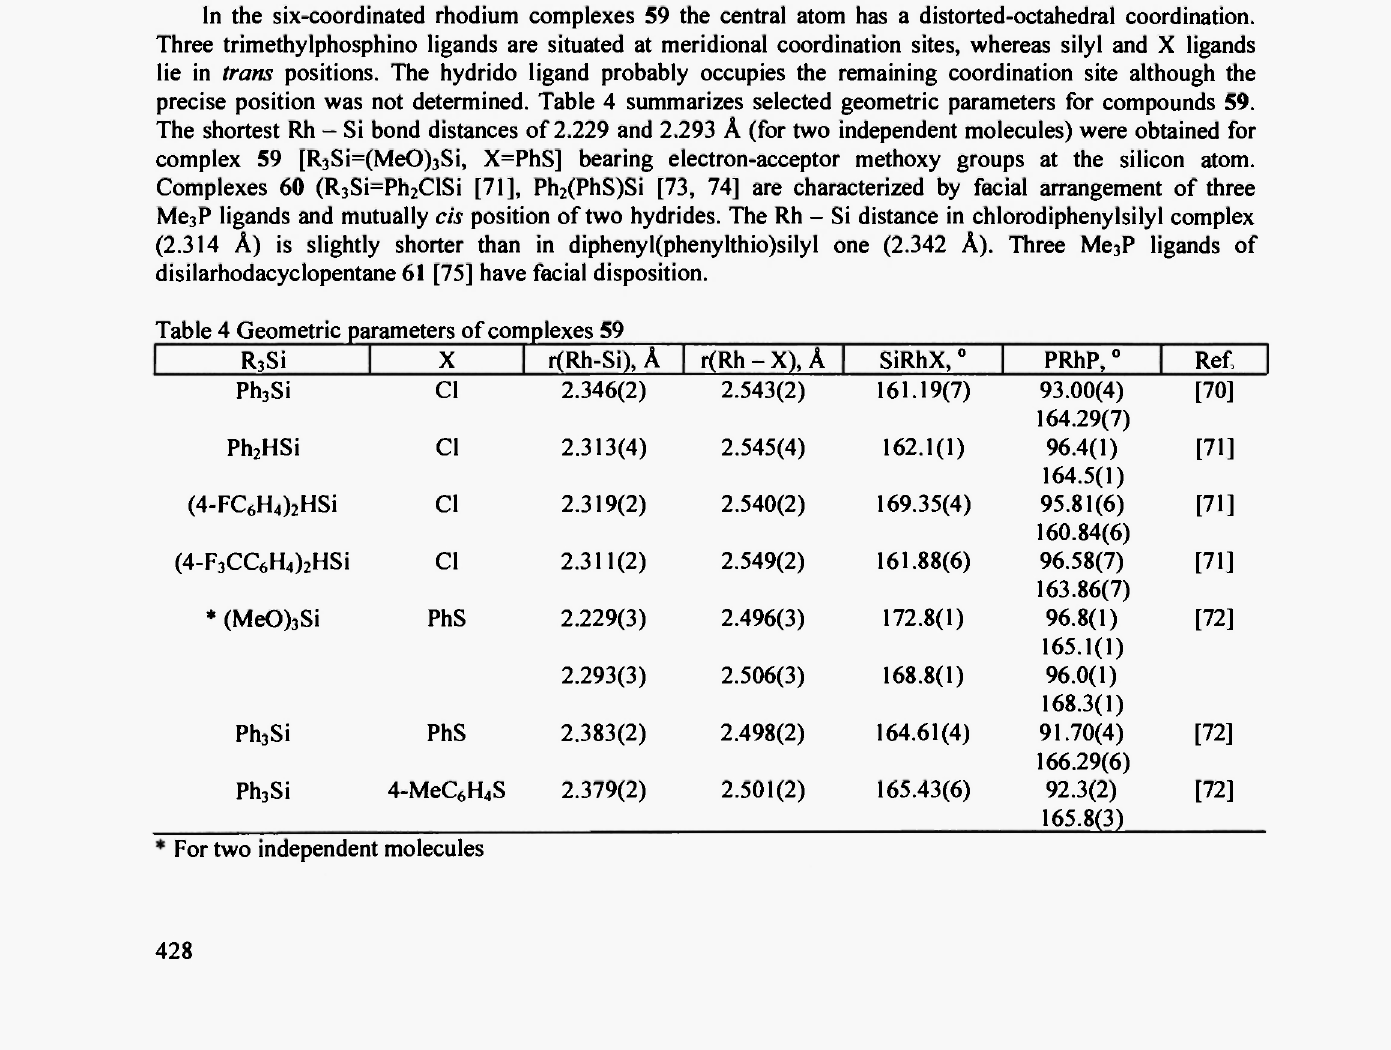
Table 4 Geometric parameters of complexes